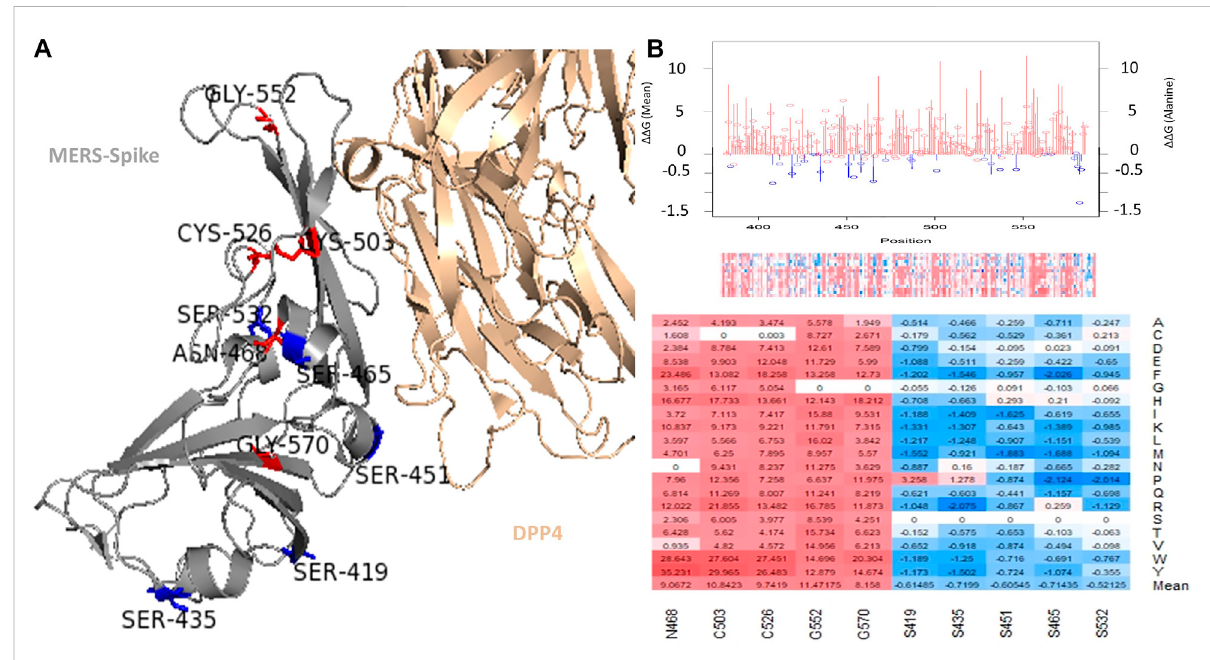
FIGURE 3 Top mutations in the MERS-CoV S RBD. (A) Illustrates the top mutations in the MERS-CoV S RBD, which is shown in complex with the DPP4 receptor. (B) Depicts the energy landscape of the MERS-CoV S protein and top mutations in the MERS-CoV. The line graph depicts the mean ΔΔ G,withredlinesindicating destabilizationandbluelinesindicating stabilization.Thebubblesindicatethepredicted ΔΔ Gofalaninemutations.The MERS-CoV S protein heatmap is shown beneath the line graph. The stability heatmap is directly beneath the line graph. The bottom of panel B displays the top positions with respect to mean stabilization and